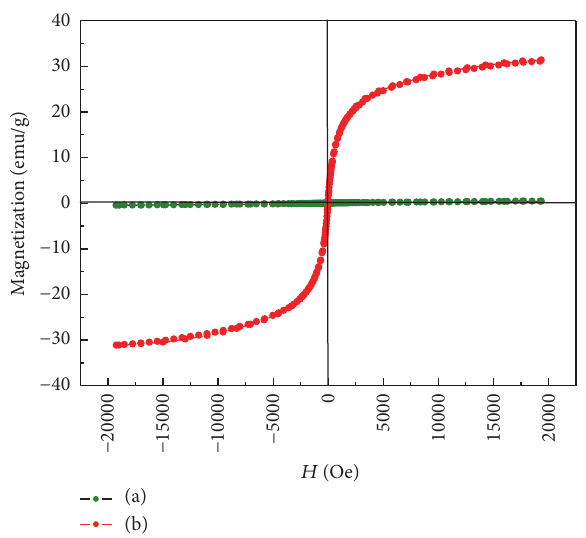
Figure 8: Room temperature hysteresis curves of magnetite with (a) Fe(OH) 3 @PMMA composite microspheres and (b) magnetic